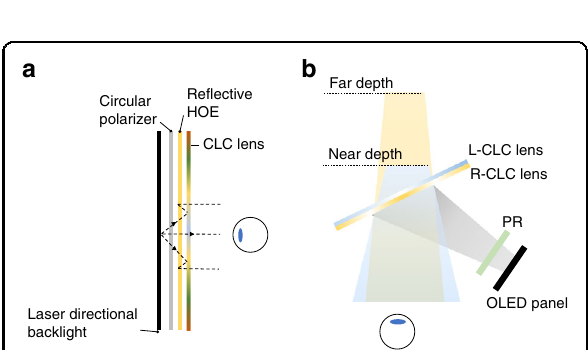
Fig. 15 Schemes for on-axis CLC lens and applications in AR/VR. a Ultra-compact Pancake VR display with only HOEs. b Dual-depth AR display. PR: polarization rotator. L-CLC lens: LCP response; R-CLC lens: RCP